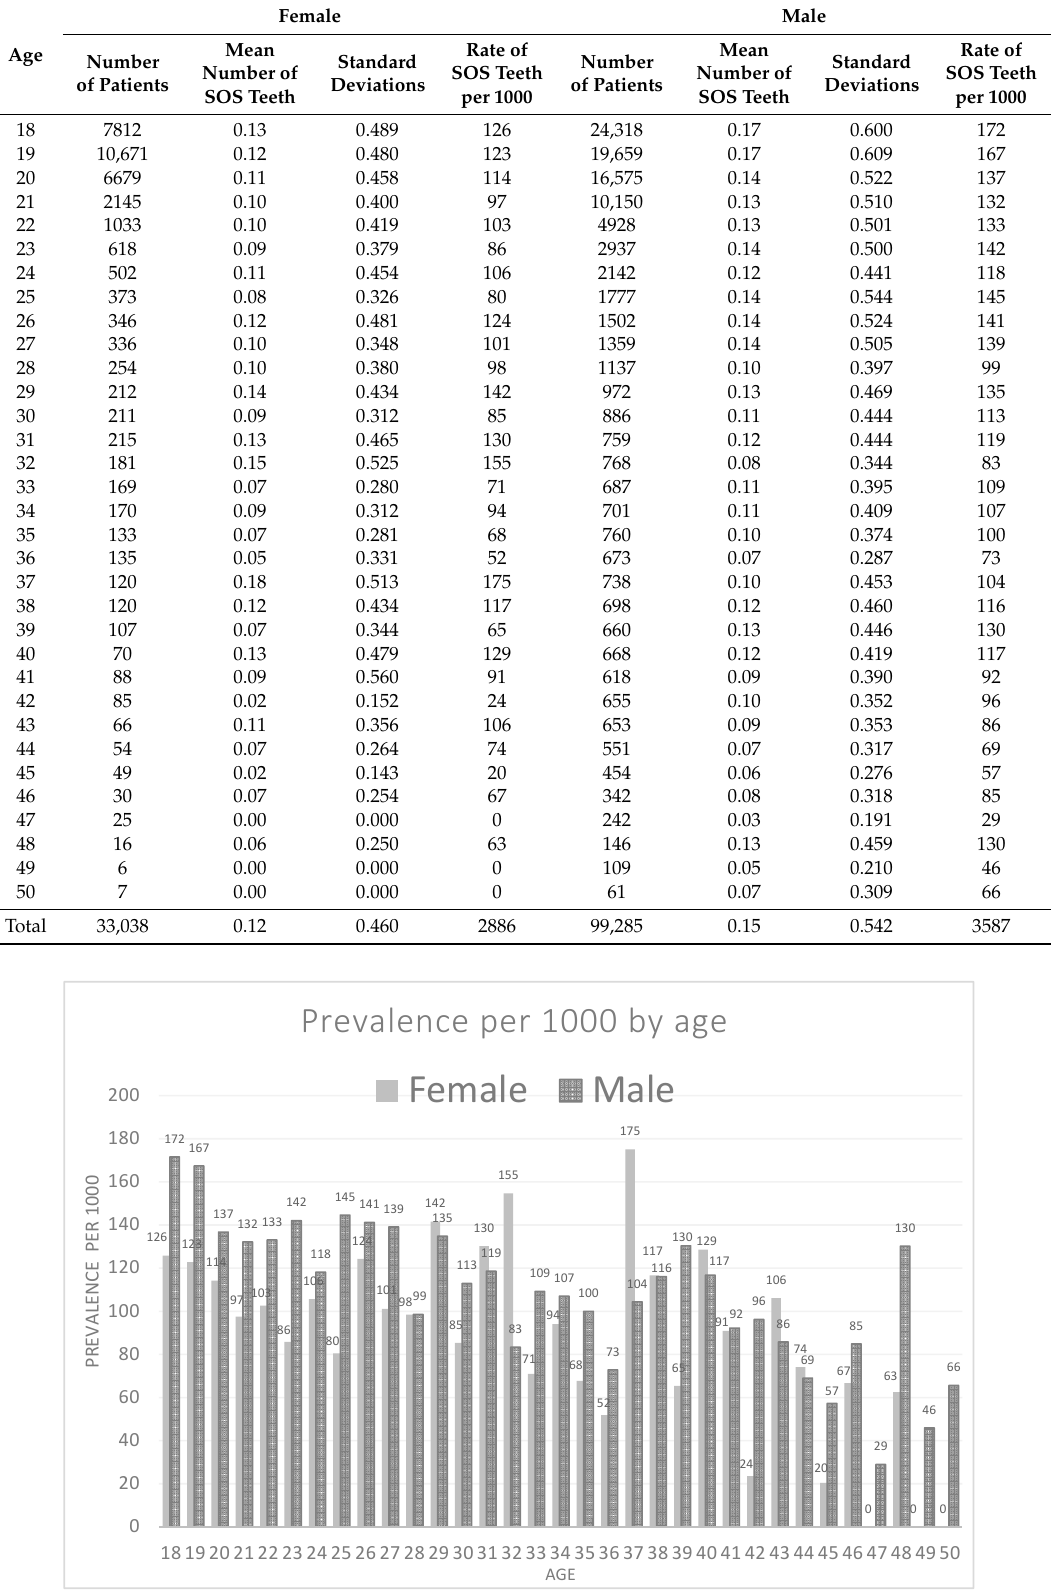
Table 4. The mean number of SOS teeth and the rate of SOS teeth per 1000 by age and sex. Female Male Mean Age Number Number of of Patients